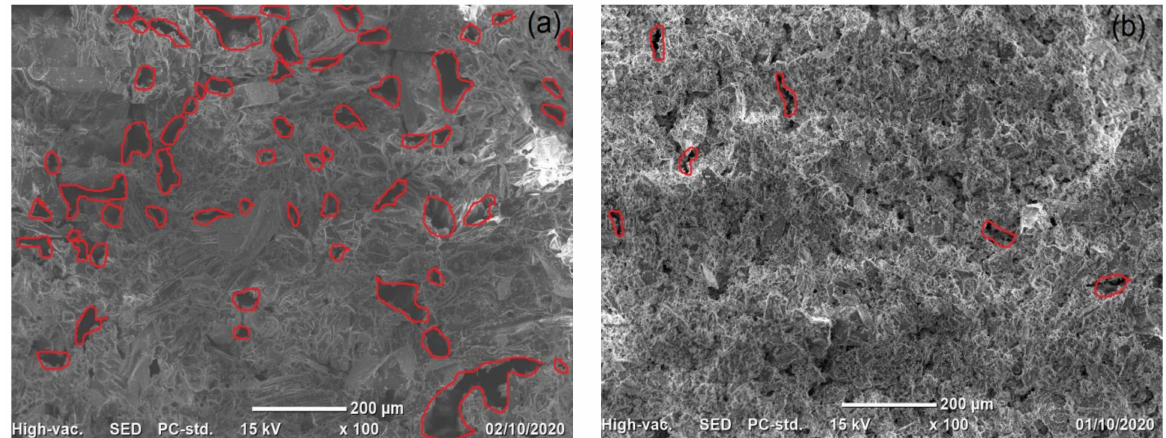
Figure 3. SEM micrographs for ( a ) VPum and ( b )